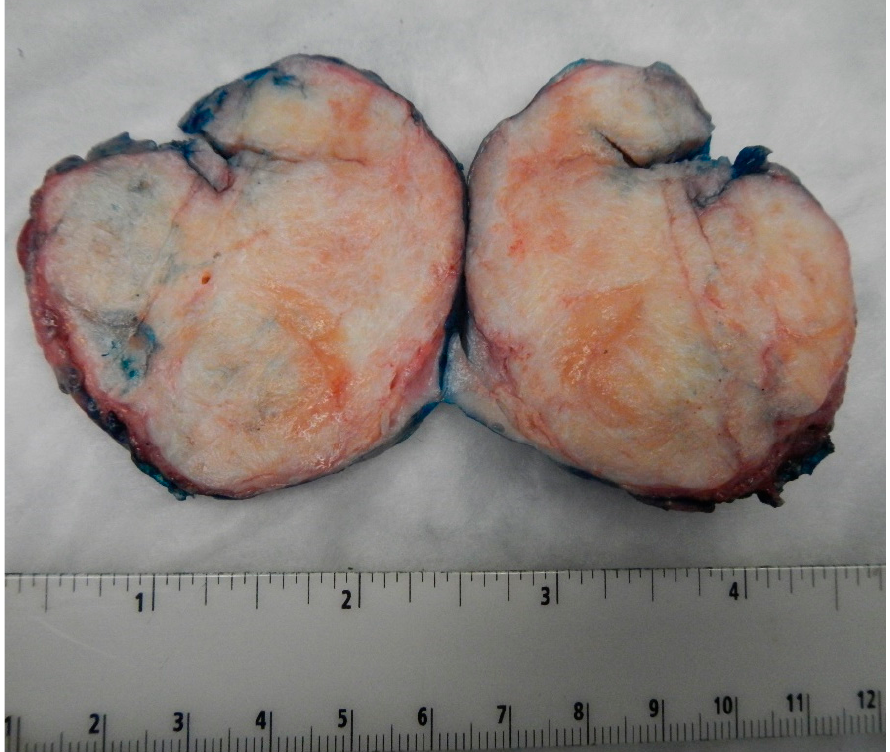
Figure 1. Image of the largest tumor in our cases series measuring 7.5 cm in maximum dimension. Notice the well-circumscribed outlines of the tumor and the tan-white firm cut surface, like those seen in ovarian fibromas.